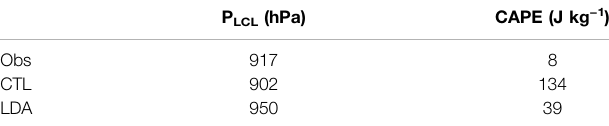
TABLE 3 | Comparison of pressure of lifting condensational level (P LCL , unit: hPa) and convective available potential energy (CAPE, unit: J kg − 1 ) between in-situ sounding and simulations of control experiment (CTL) and lightning data assimilation experiment